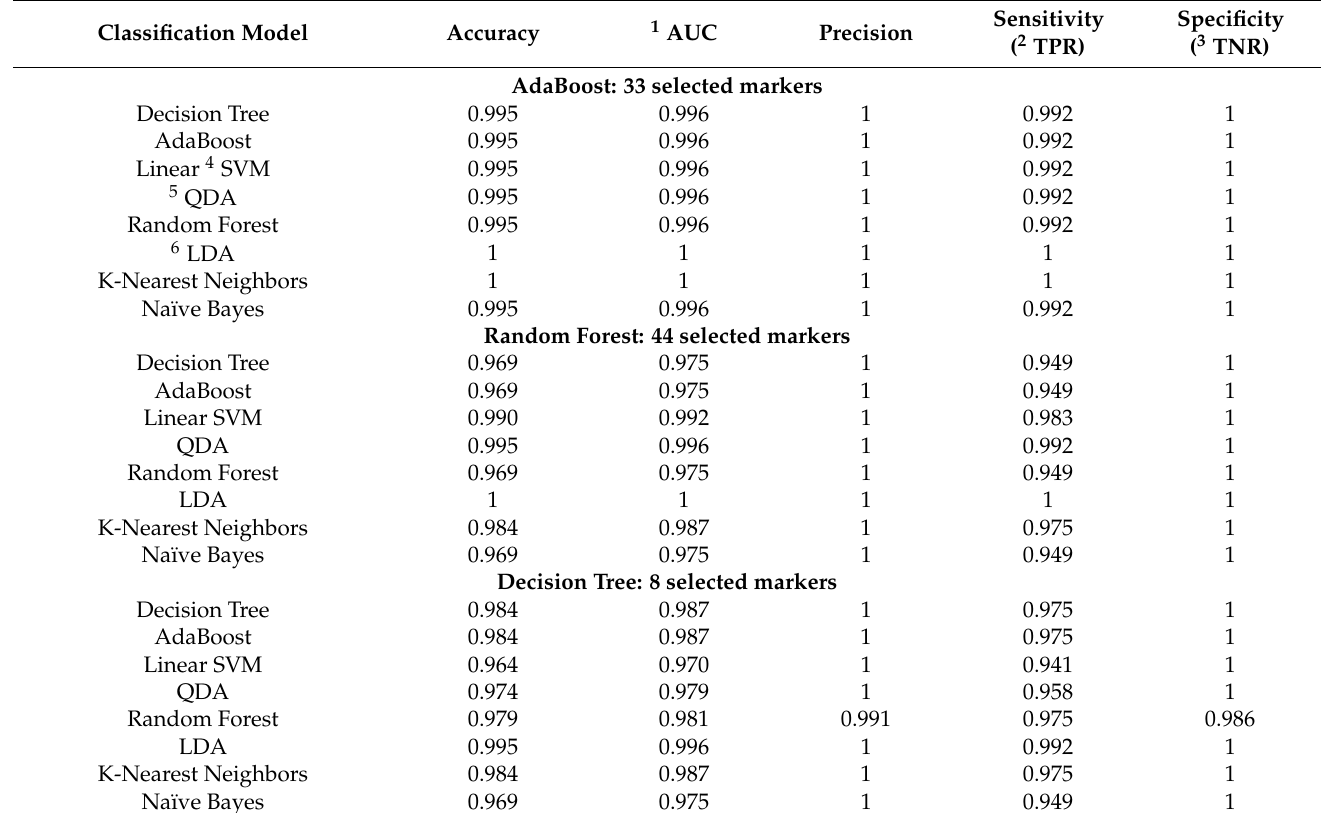
Table 2. Accuracy of identifying the target (case) chicken population by using the minimum number of SNP markers (feature selection) selected by different machine learning